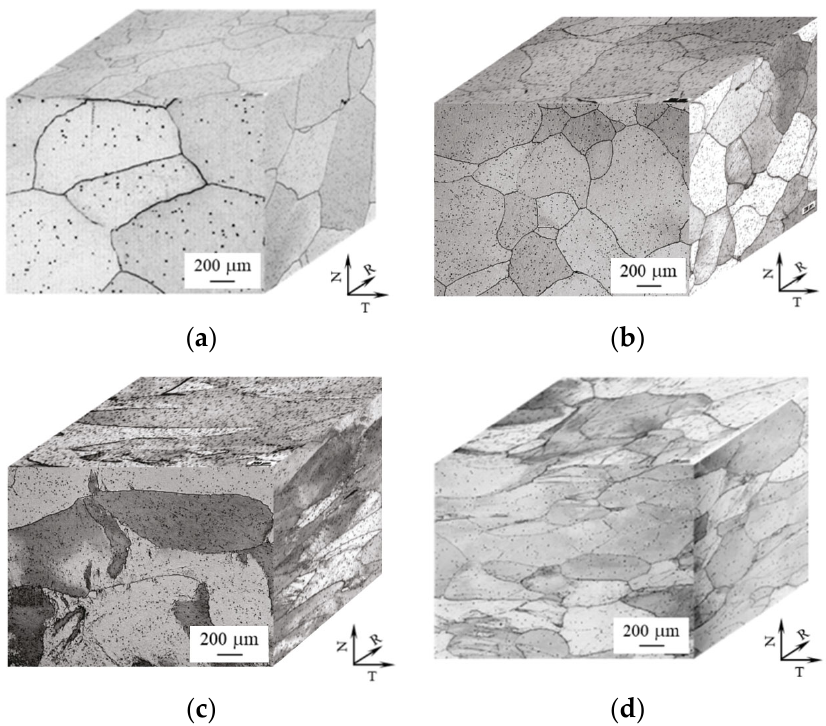
Figure 2. Typical, as ‐ rolled microstructures of ( a ) 17Cr1_1 [19], ( b ) 17Cr1_2, ( c ) 17Cr1_3, and ( d ) 17Cr2_4 [19] HiperFer steel (R: rolling; T: transversal; N: normal direction of rolled plate material; obtained from optical micrographs, taken from the three directions).